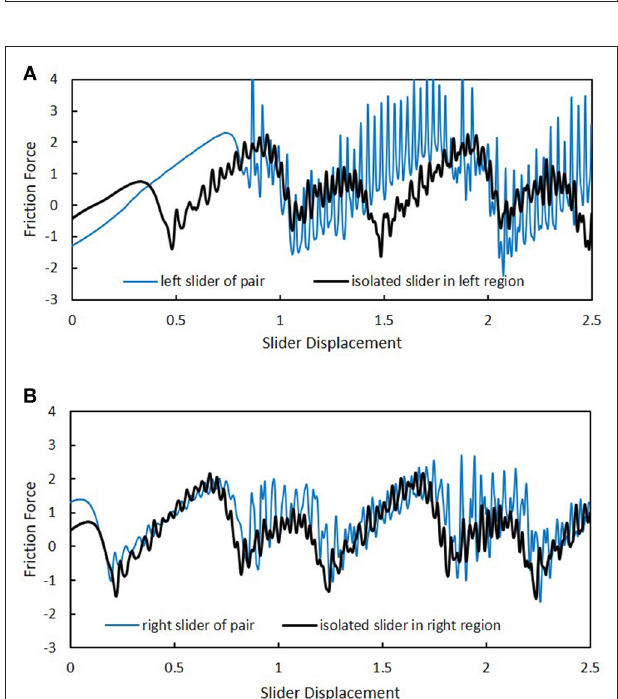
FIGURE 10 | Comparison of slider friction in cases with and without a pairing slider. Pair is separated by √ 2 along the x- axis. (A) Friction experienced by left slider of pair and by isolated slider at same locations. (B) Friction experienced by right slider of pair and by isolated slider at same